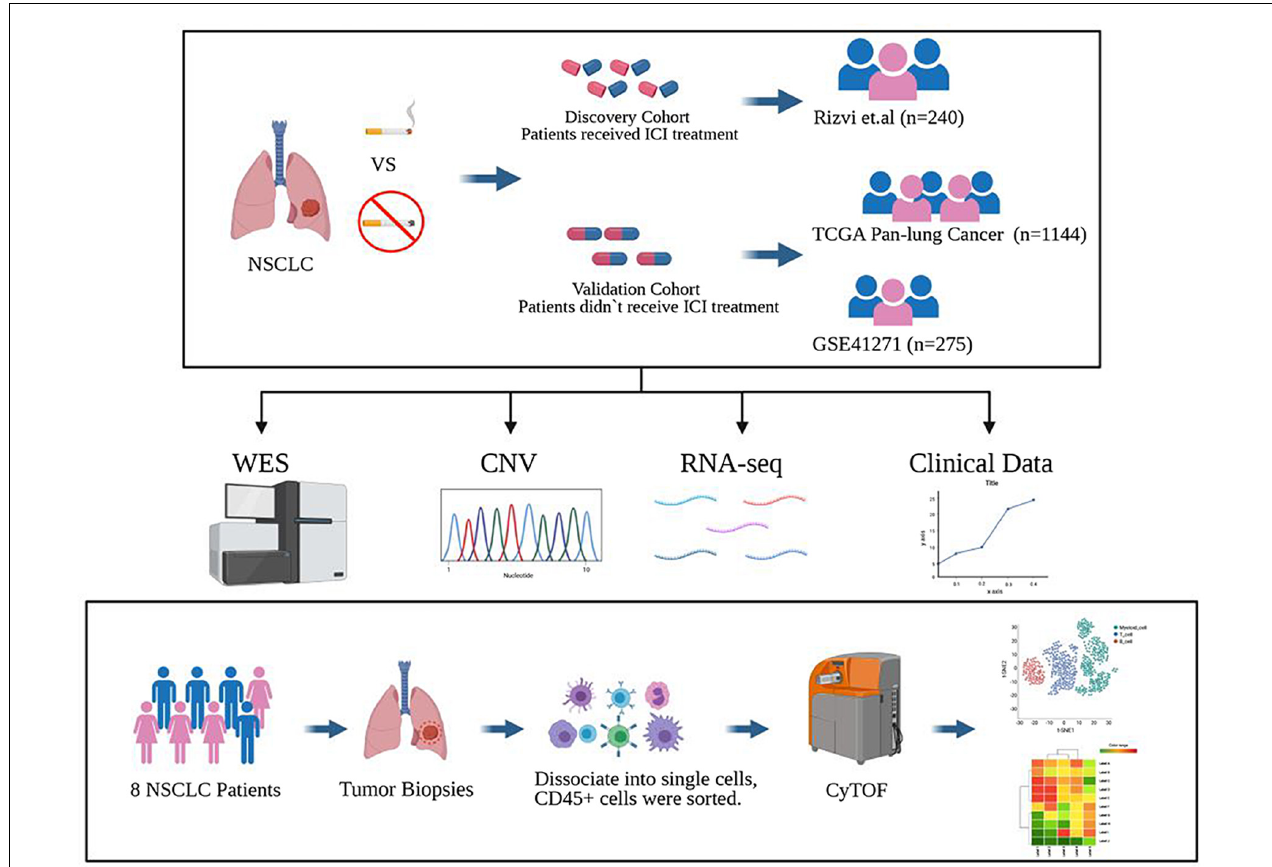
FIGURE 1 | Study design. The discovery cohort from the MSKCC database included 240 NSCLC patients treated with ICIs. The validated cohorts from the TCGA database and GEO database (GSE41271) that were not treated with ICIs contained 1,144 patients and 275 patients. Also, a cohort of 8 cases of NSCLC who did not receive ICI treatment collected from Zhujiang Hospital of Southern Medical University underwent CyTOF experimental verification. Figure created with BioRender.com.